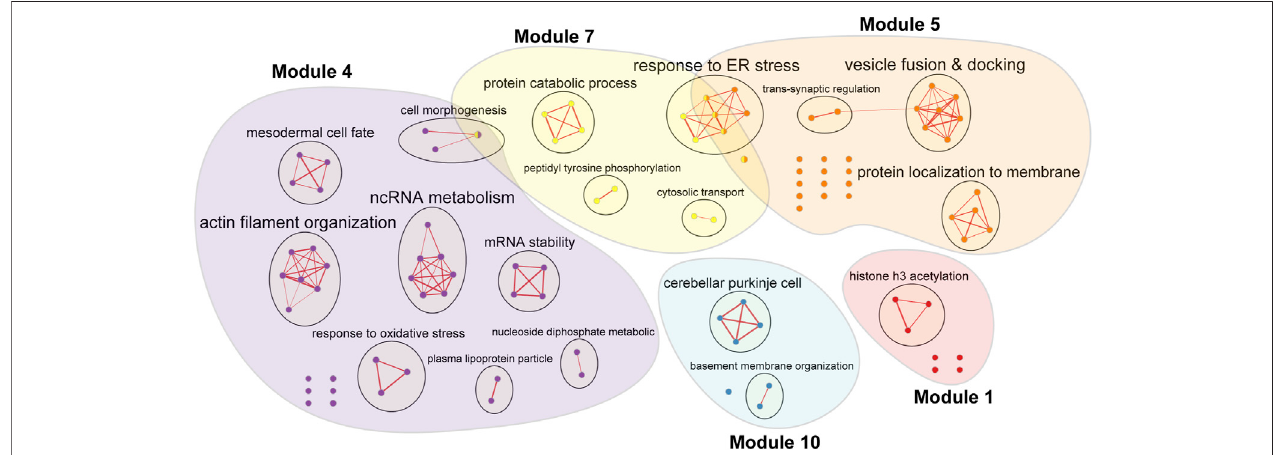
FIGURE 4 | Enrichment Map of fi ve key modules with hub lncRNAs contributing to the modular regulation induced by bipolar disorder drugs. Enriched gene sets are represented as nodes, while edges connect the similar gene sets together. Nodes are coloured by the module they enriched with the coloured patches covering all enriched gene sets by module; one node might be enriched in multiple modules. The bigger the node, the higher the number of genes found in the gene set. The thicknessofeachedgeisproportionaltothenumberofmutualgenesbetweennodes.Genesetswithsimilarfunctionsareclusteredandlabelledbasedonthemain theme they belonged to. Abbreviation: ER – endoplasmic